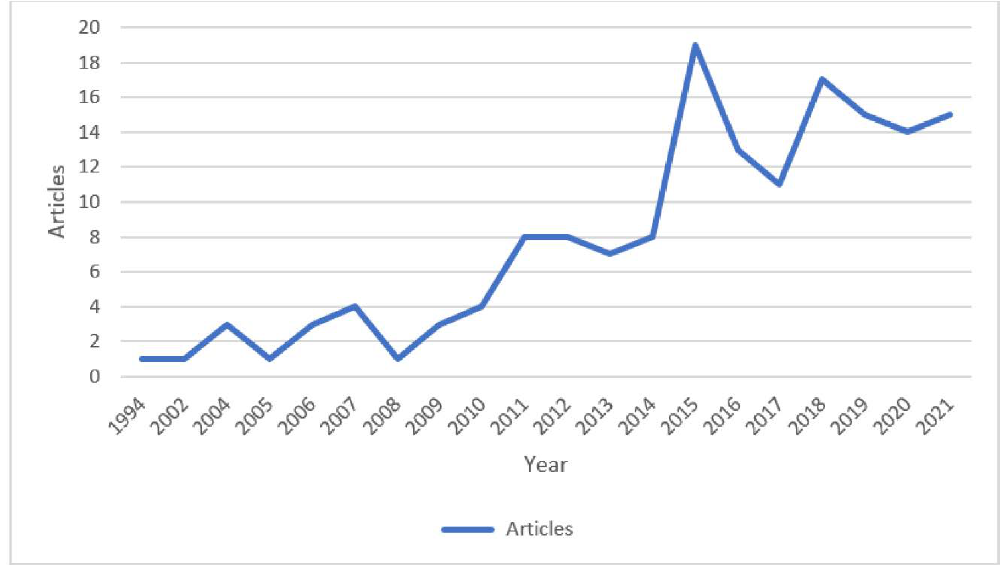
Figure 2. Annual scientific production of articles.